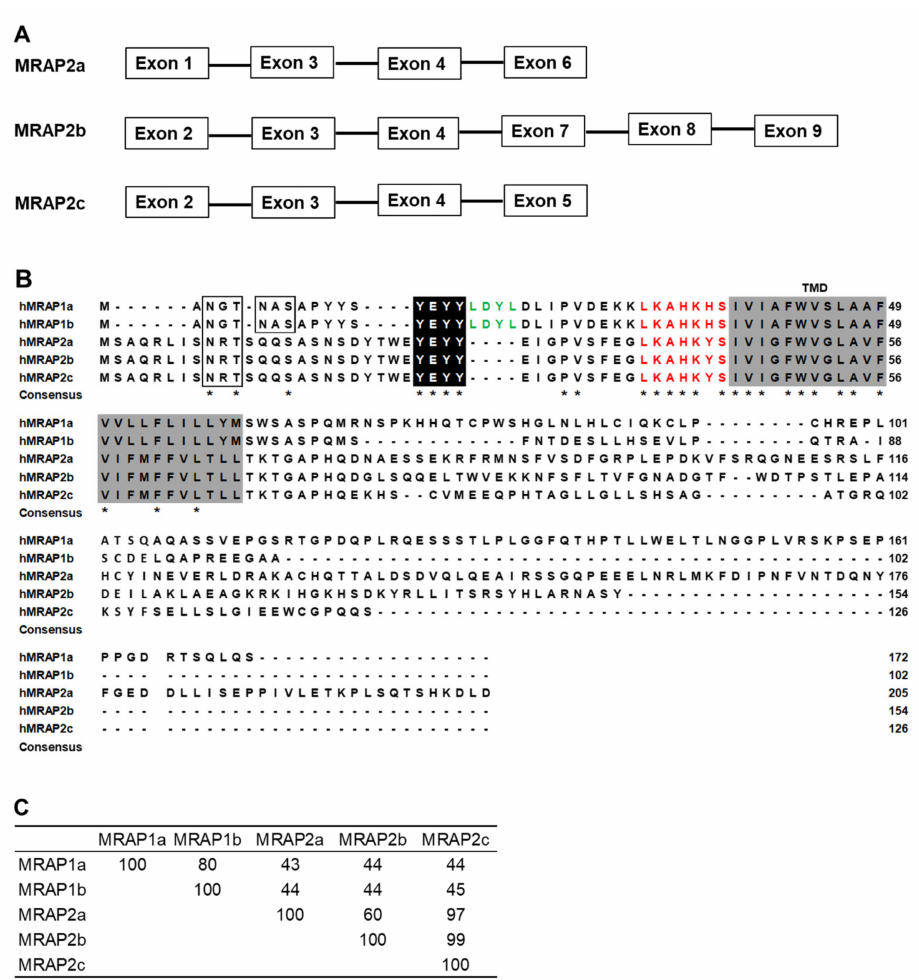
Figure 1. Schematic diagram of the human MRAP2 splice variants ( A ), comparison of amino acid sequences of human MRAP1s and MRAP2s ( B ), and amino acid sequence identities of MRAP1s and MRAP2s ( C ). Open boxes indicate potential N-linked glycosylation sites. Dark shadows show conserved motifs (YEYY) in both MRAP1 and MRAP2. The green color indicates the activation motif (LDYL). LKAHKHS (red color) in MRAP1s and LKAHKYS (red color) in MRAP2s are required for dual topology. Transmembrane domains are shown in shaded boxes. Asterisk (*) denotes the same amino